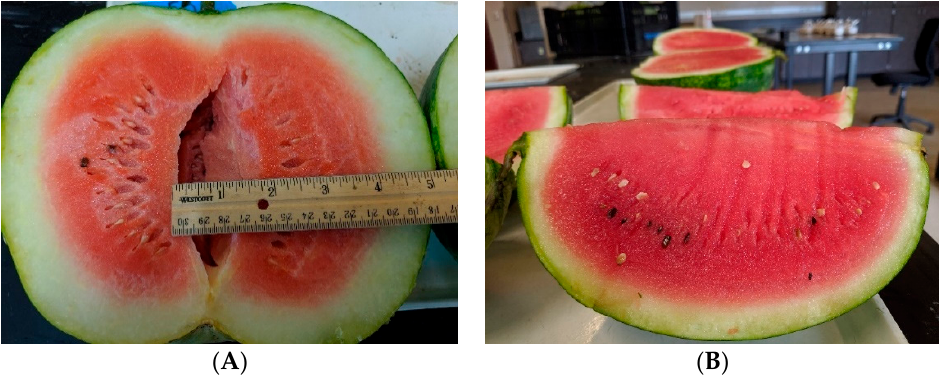
Figure 1. Hollow heart ( A ) and black seed formation ( B ) in grafted triploid watermelon.